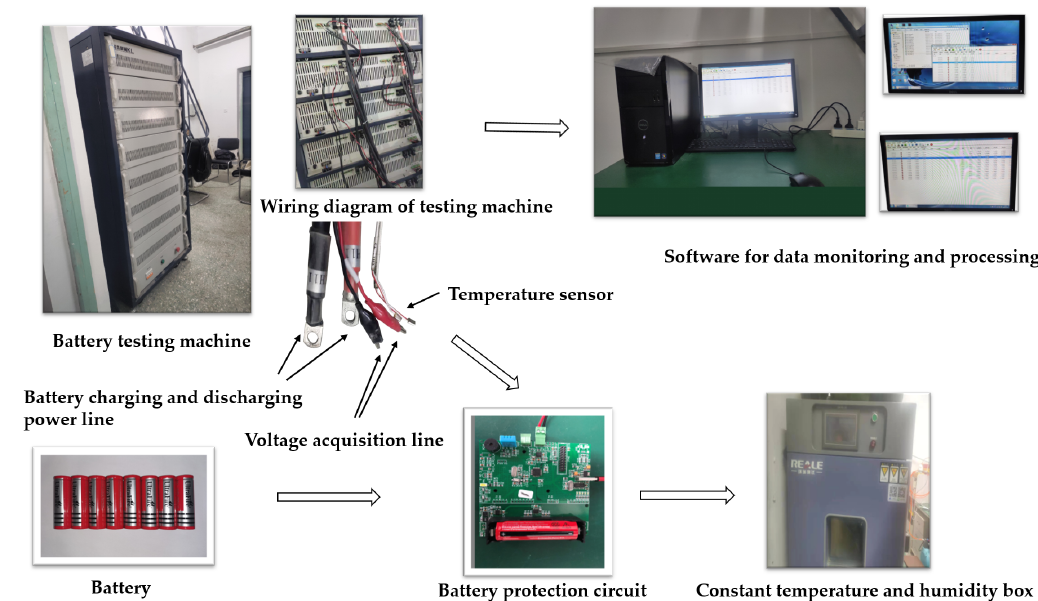
Figure 8. Battery test platform.